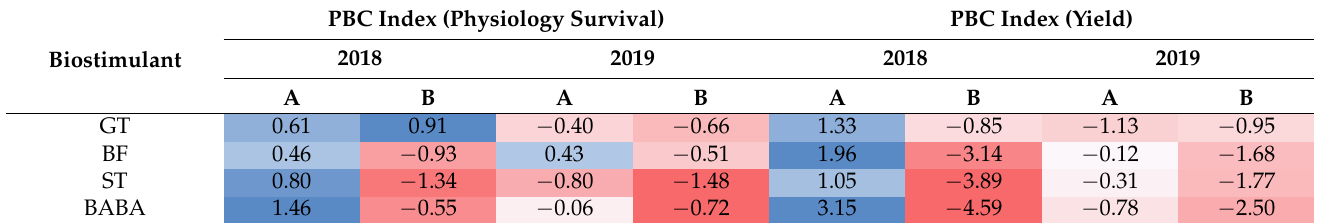
Table 1. Plant Biostimulant Characterization (PBC) index for plant physiology and survival or production yield parameters in plants of Vitis vinifera var. Tempranillo from two subplots (A and B) sprayed with distilled water (C), BABA, or three commercial biostimulants (Greetnal (GT), Basofoliar (BF, or SoilExpert (ST)) in the 2018 and 2019